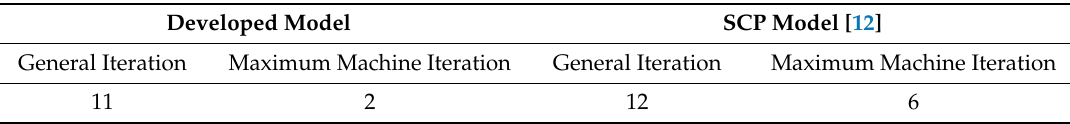
Table 1. Iteration number of models in the 34 bus test system.